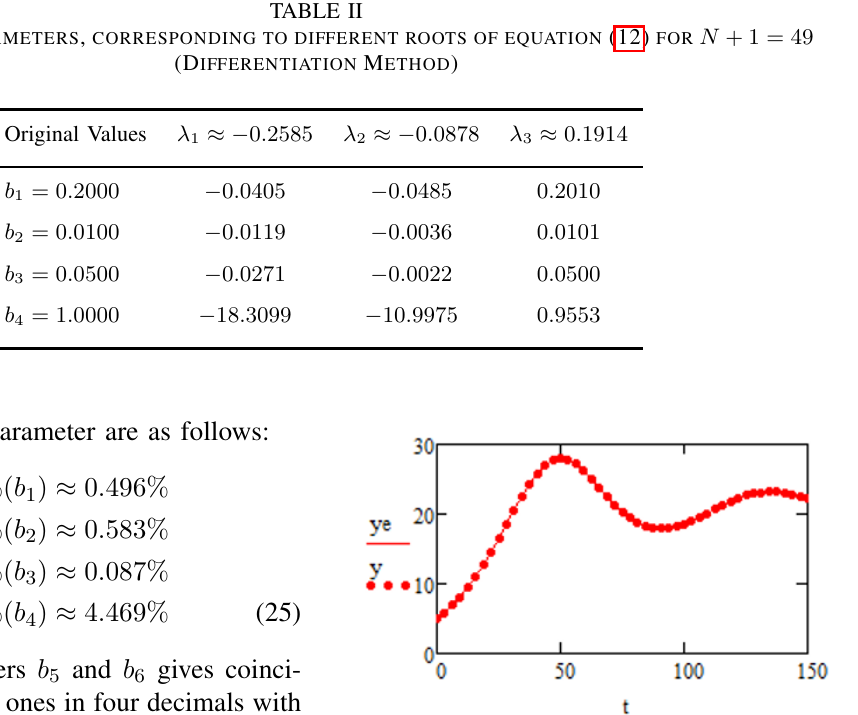
V ALUES OF b - PARAMETERS , CORRESPONDING TO DIFFERENT ROOTS OF EQUATION (12) FOR N + 1 = 49